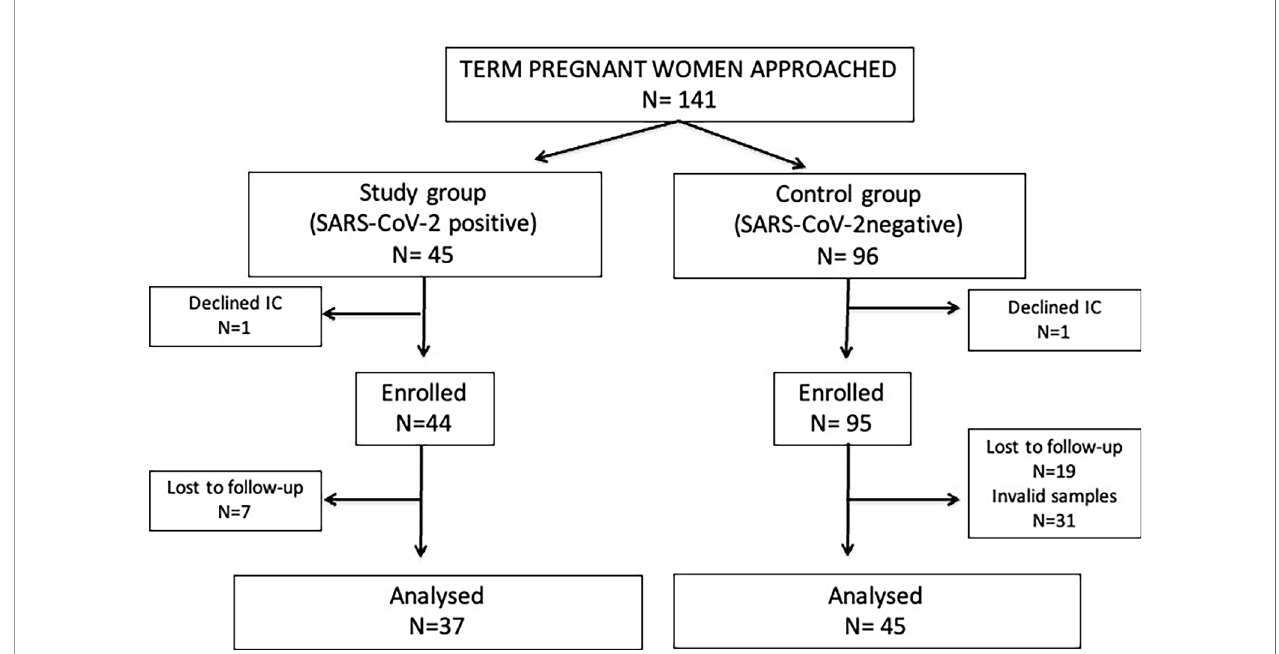
FIGURE 1 | Flow diagram of participants. IC, informed consent; Invalid samples, non-availability of all samples to be compared, inadequate sample identi fi cation or